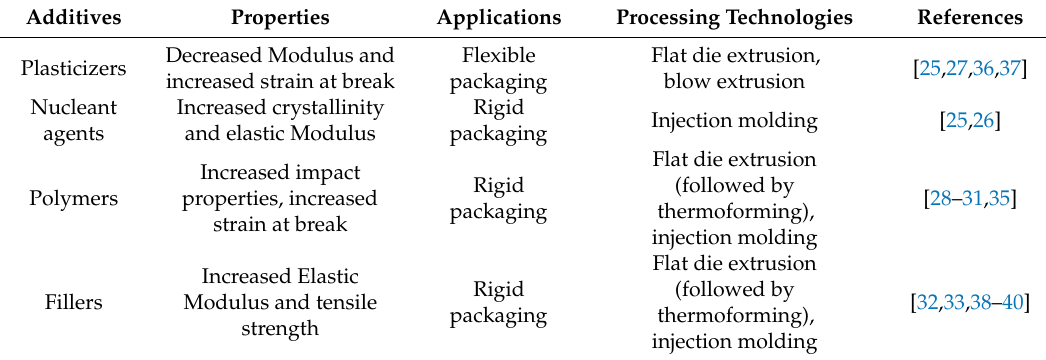
Table 2. Di ff erent additives for poly(lactic acid) (PLA) materials suitable in rigid and flexible packaging. Additives Properties